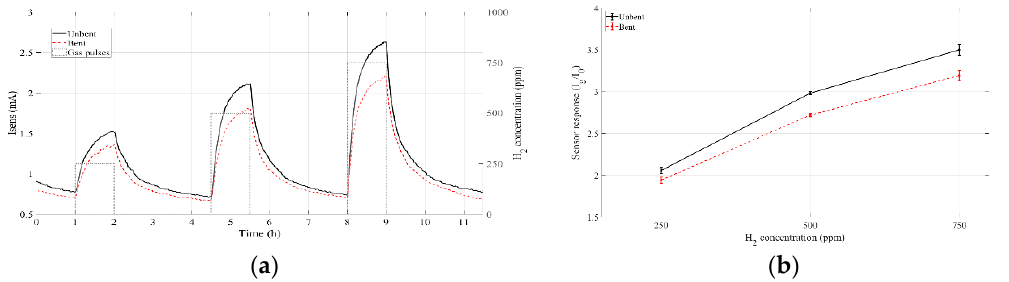
Figure 3. ( a ) Current through active layer at different concentrations of H 2 (250, 500 and 750 ppm H 2 ) and ( b ) Sensor response to H 2 concentration, before and after 50 repeated bending tests.